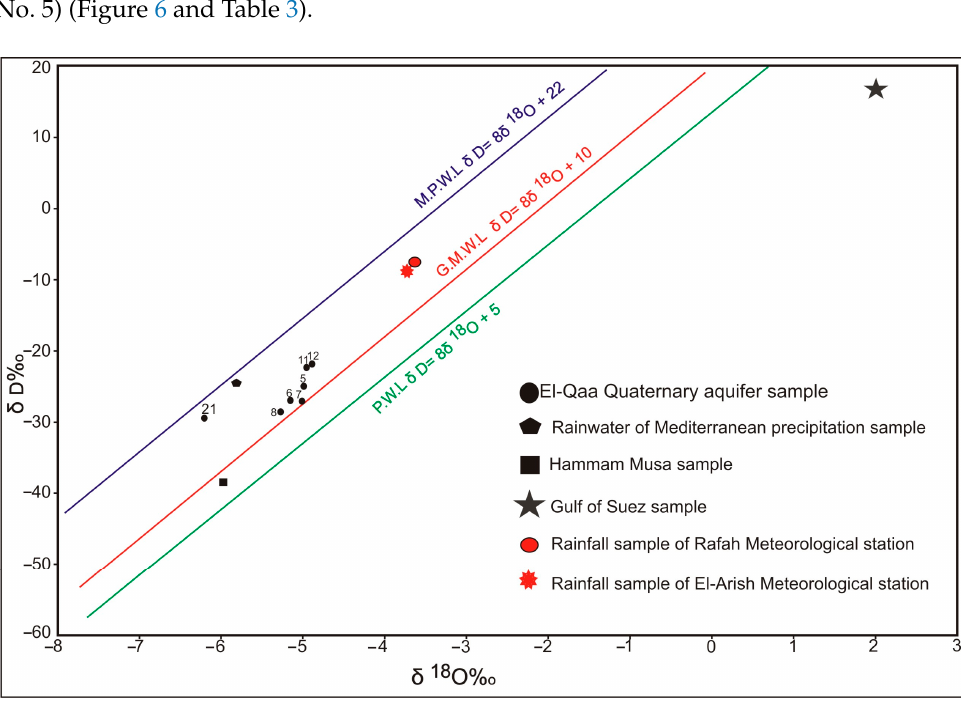
Figure 6. Environmental stable isotopes composition ( δ 18 O and δ 2H) of groundwater samples from the selected groundwater wells. Table 3. Stable environmental isotope data ( δ O 18 and δ D) for groundwater samples collected from El-Qaa Plain